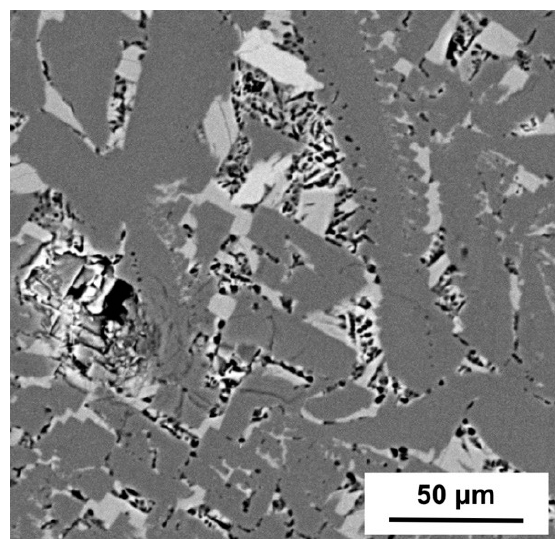
Figure 9. Typical backscattered electron micrograph of crystals in the solid film. The film was recovered after immersing the probe for 120 s in molten flux with a bulk slag temperature of 1623 K.